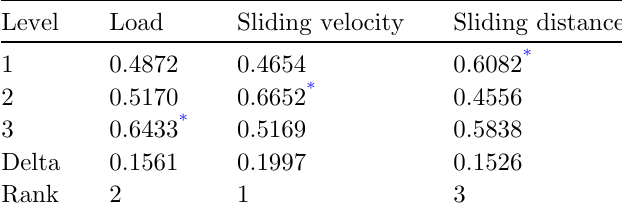
Table 6. Main effects on grey grades.